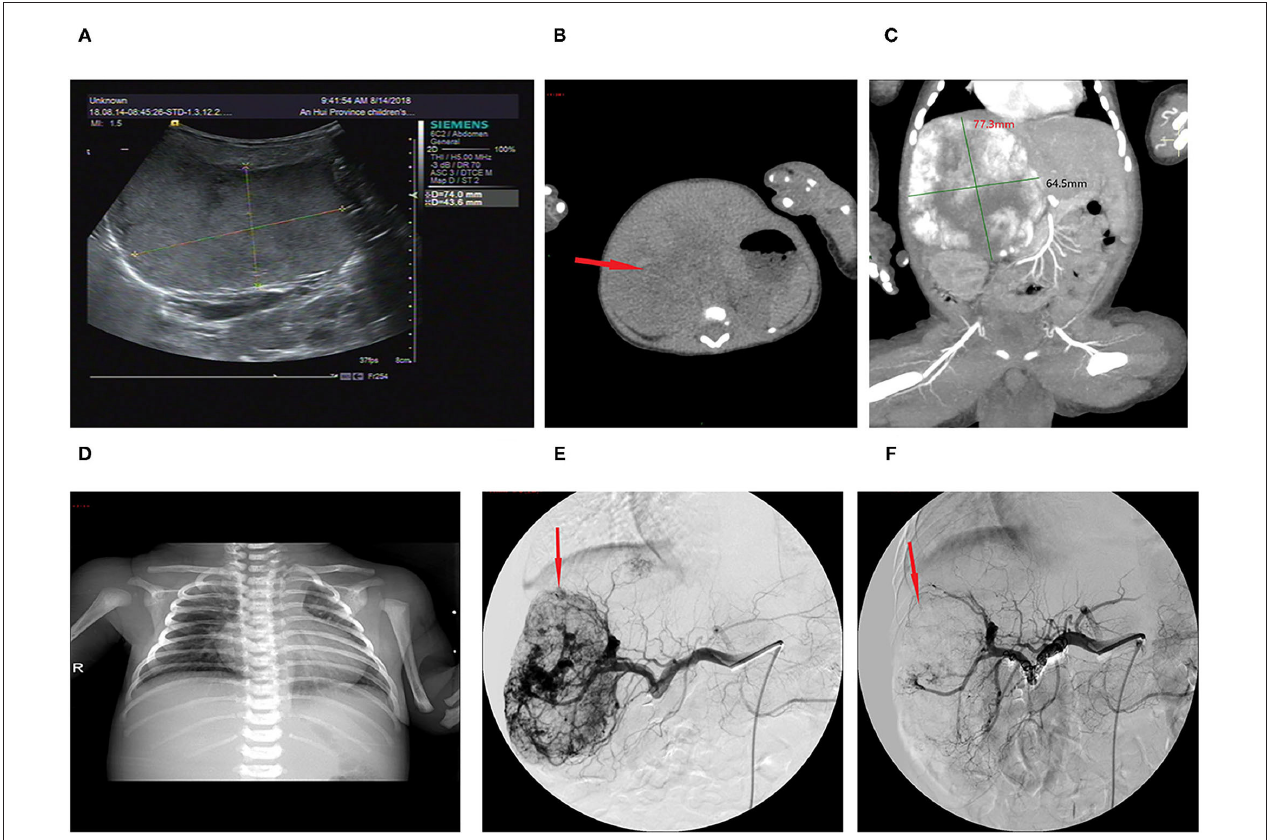
FIGURE 2 | Imaging of the hepatic hemangioma for case 6. (A) Ultrasonography showed a hyperechoic solid lesion in the liver. (B) CT showed that the lesion was a large soft tissue mass. (C) Contrast-enhanced CT showed obvious arterial phase enhancement inside the mass. (D) CXR showed enlargement of the heart shadow. (E) CTA showed an abundant tumor blood supply before embolization. (F) After TAE, more than 80% of the tumor-feeding arteries were embolized. TAE, transarterial embolization; CTA, computed tomography–angiography; CXR, chest X-ray. The red arrow indicates the lesion.